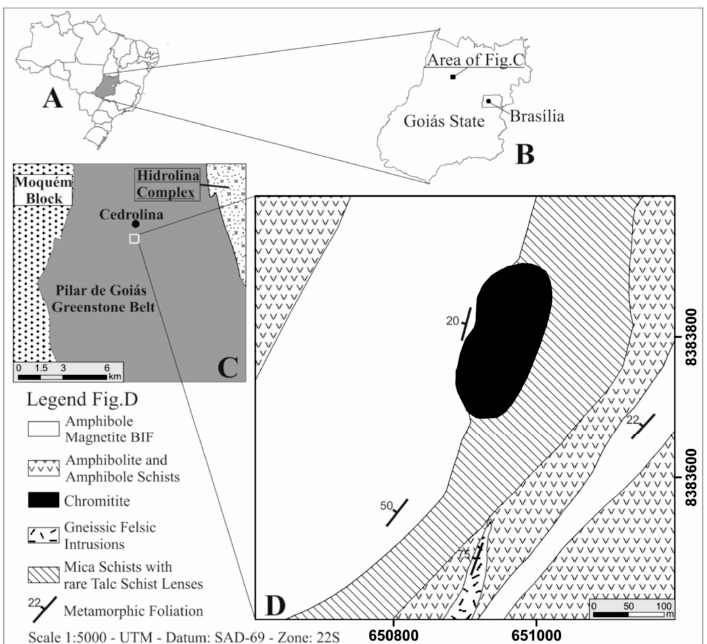
Figure 2. Geological sketch maps of Cedrolina chromitites ( A,B ) Geographical location of the studied area; ( C ) General geology of the central-northern Pilar de Goiás greenstone belt area simplified after [33]; ( D ) Detailed geological map of a small portion of the Cedrolina Formation where the investigated chromitites occur (after [23,32]).